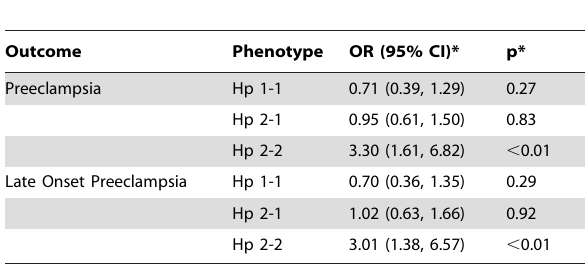
Table 3. Odds ratios for effect of treatment in Hispanic women in the weighted pooled cohort.